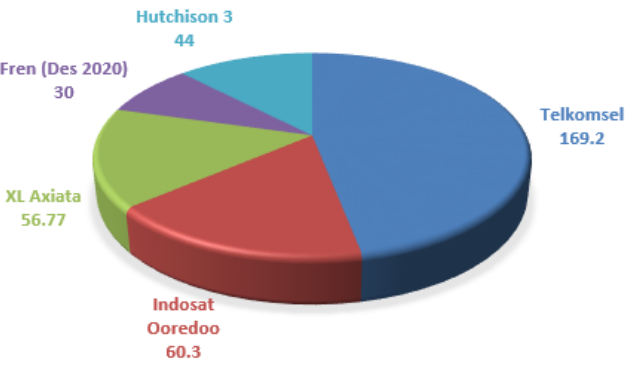
Figure 4. The proportion of each service operator’s subscribers in Indonesia (million) [38].